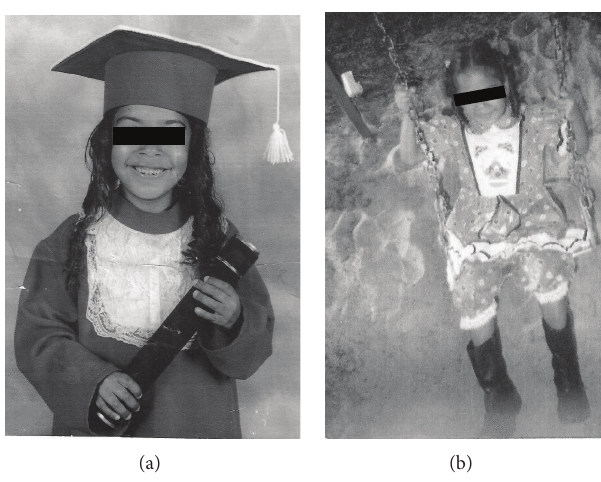
Figure 1: The healthy patient at 9 years of age.